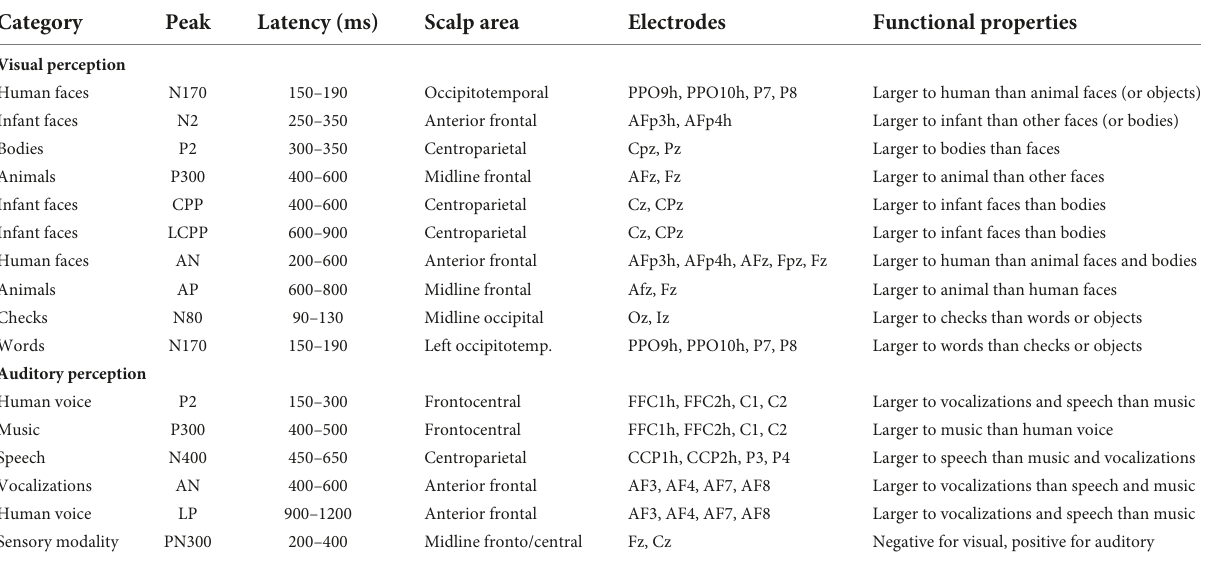
TABLE 5 Functional properties of visual and auditory components of ERPs showing a statistically significant (99.99% or higher) sensitivity to a specific semantic category of